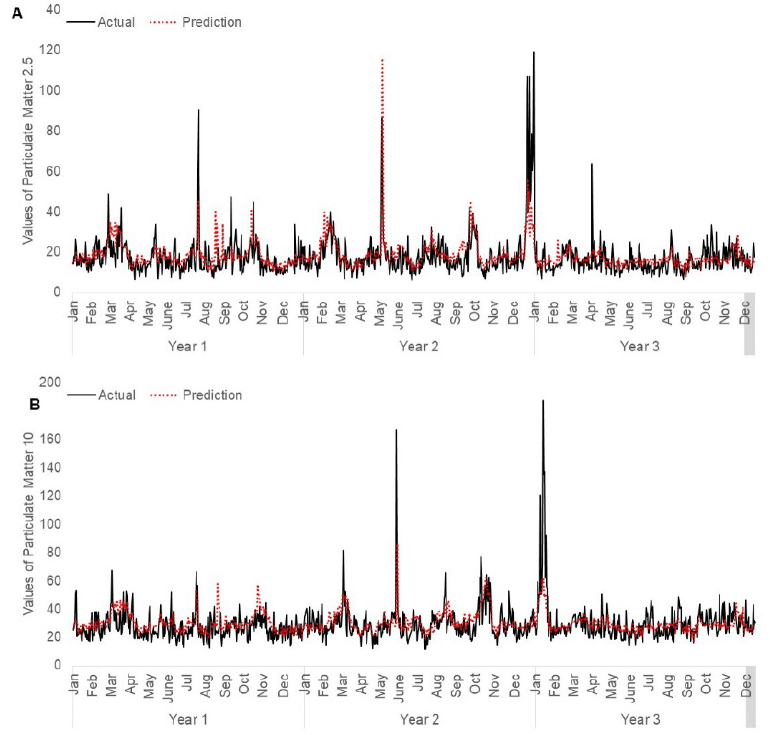
Figure 5. Comparison of actual and predicted air quality values using random forest model in Singapore: ( A ) PM 2.5 and ( B ) PM 10 Testing data (30%) is randomly selected from the dataset (2007–2018).